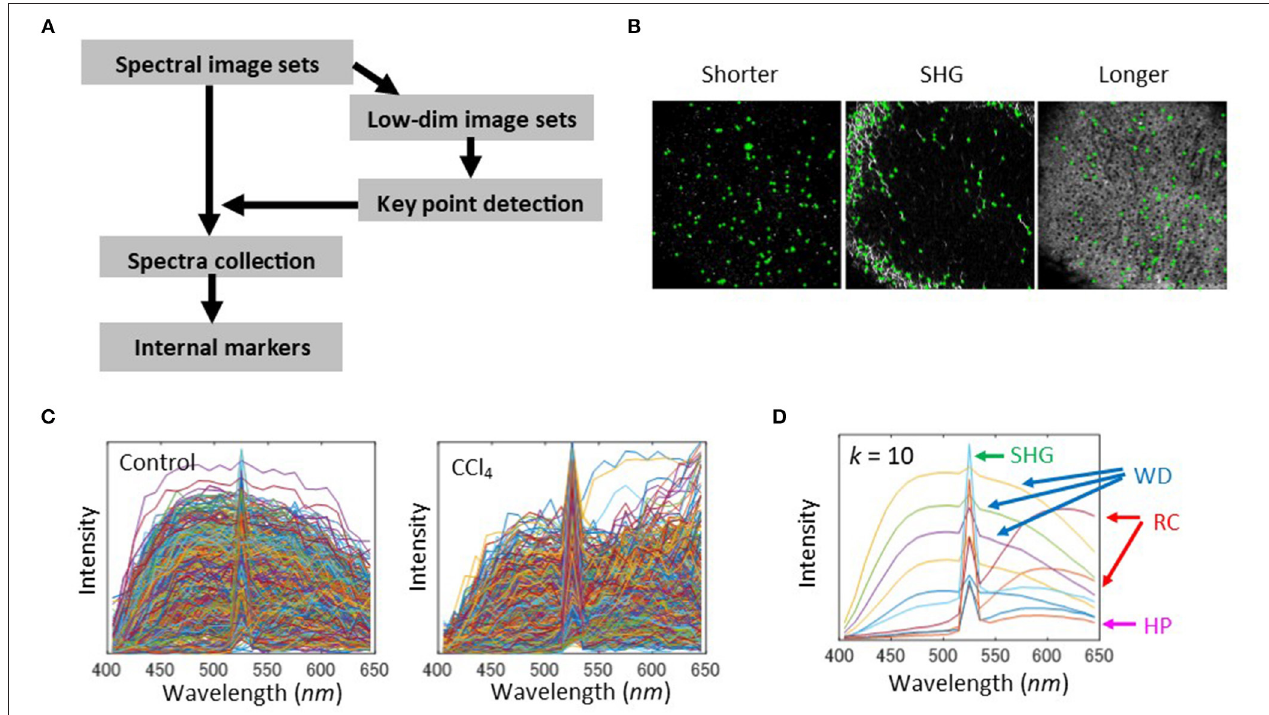
FIGURE 3 | Selection of internal markers. (A) Schematic of the image processing workflow. First, the dimensionality of spectra was reduced by defining color bands of shorter wavelengths 400–500nm, SHG 520–530nm, and the longer wavelengths 550–650nm. The lower dimensional images were generated by averaging the spectra intensities among each of the bands. Using these image sets, a feature detection algorithm was applied to detect key points in the images. With the coordinates of the detected points, spectra were collected from the original spectral image sets and were stored in a spectral pool. Next, the pooled spectra were quantized to the centroid values of a k -means cluster, in which each cluster represents a spectral marker. (B) Key point extraction was by FAST feature detection algorithm. The results for bandpass images with shorter wavelengths, SHG, and longer wavelengths were shown. The detected points were denoted as green cross marks. (C) Spectral profiles collected from the detected key points for the 2-weeks control and CCl 4 model. (D) Quantization of the collected spectra for the cluster number k = 10 of k -means clustering. Interpretation of quantized spectra is indicated for HP, SHG, WD, and